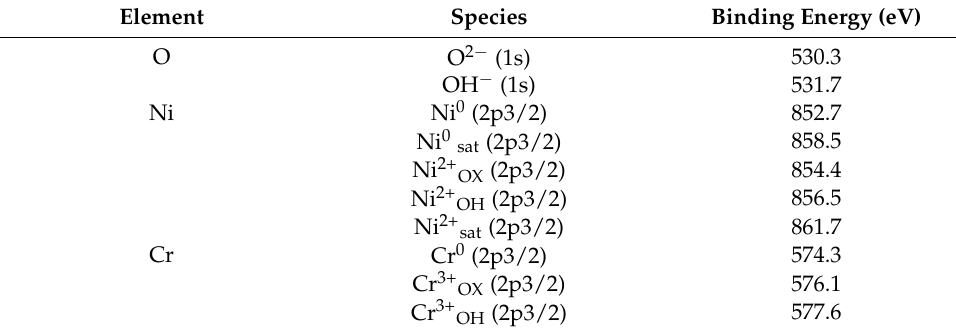
Figure 6. The O 1s, Ni 2p3/2 and Cr 2p3/2 core lever spectra outside the crevice of the crevice sample exposed to 290 °C NaCl solution. Table 2. Binding energies of XPS